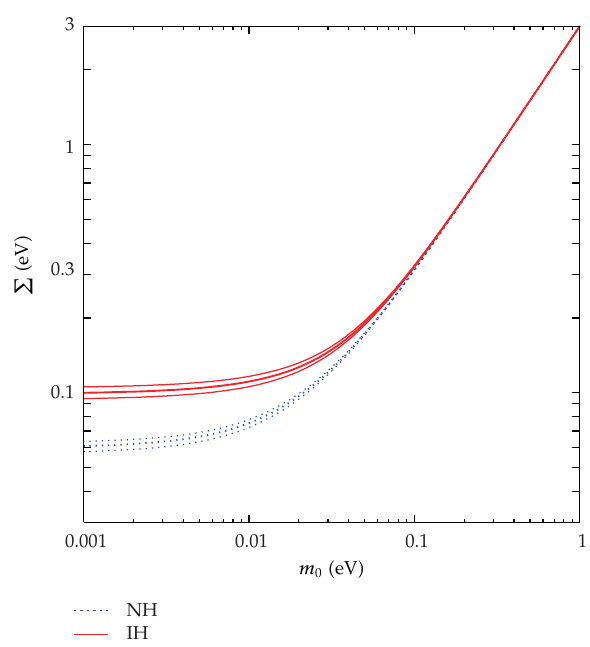
Figure 5: Allowed values of the total neutrino mass as a function of the lightest state within the 3 σ regions of the mixing parameters in (cid:2) 5.3 (cid:3) . Blue dotted (cid:2) red solid (cid:3) lines correspond to normal (cid:2) inverted (cid:3) hierarchy for neutrino masses, where m 0 (cid:7) m 1 (cid:2) m 0 (cid:7) m 3 (cid:3)